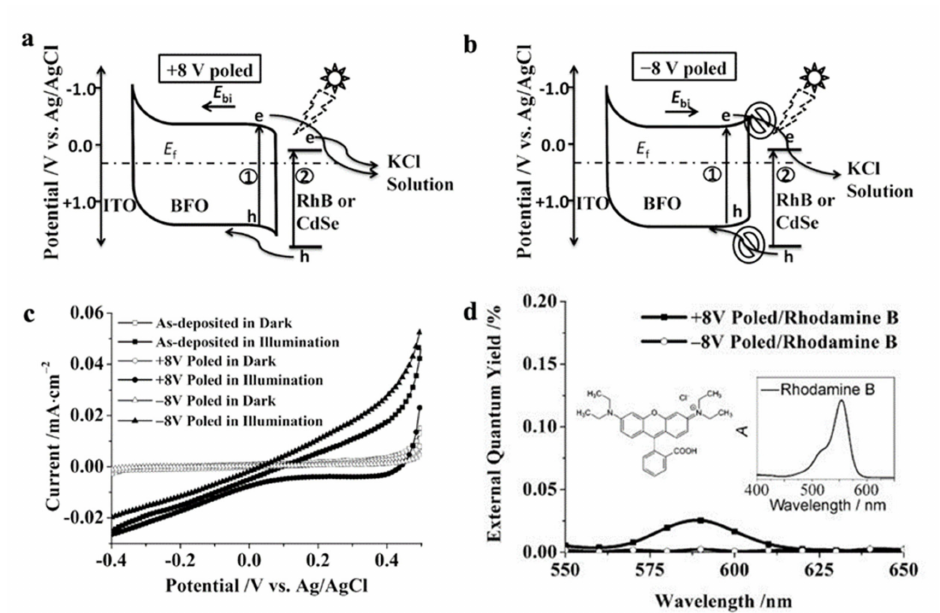
Figure 3. Schematic representations of the mechanisms in photo-excited charge transfer from BFO films to the electrolyte 1 (cid:13) and from excited surface modifiers to the BFO films 2 (cid:13) after the BFO films were ( a ) positively and ( b ) negatively poled of 8 V. ( c ) Photocurrent–potential characteristics of the photoelectrodes with different polarization states. ( d ) External quantum yield spectra of the BFO electrodes measured with 50 mm Rhodamine B. Inset: the absorption spectrum of Rhodamine B in water. Adapted with permission from ref. [69], copyright: 2014, Wiley.